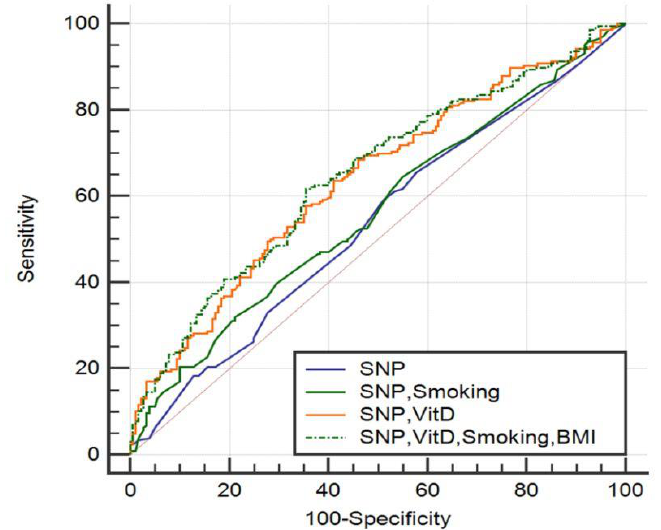
Figure 3. ROC curve adjusted for the single nucleotide polymorphisms (SNP), vitamin D, body mass index (BMI), and smoking models.